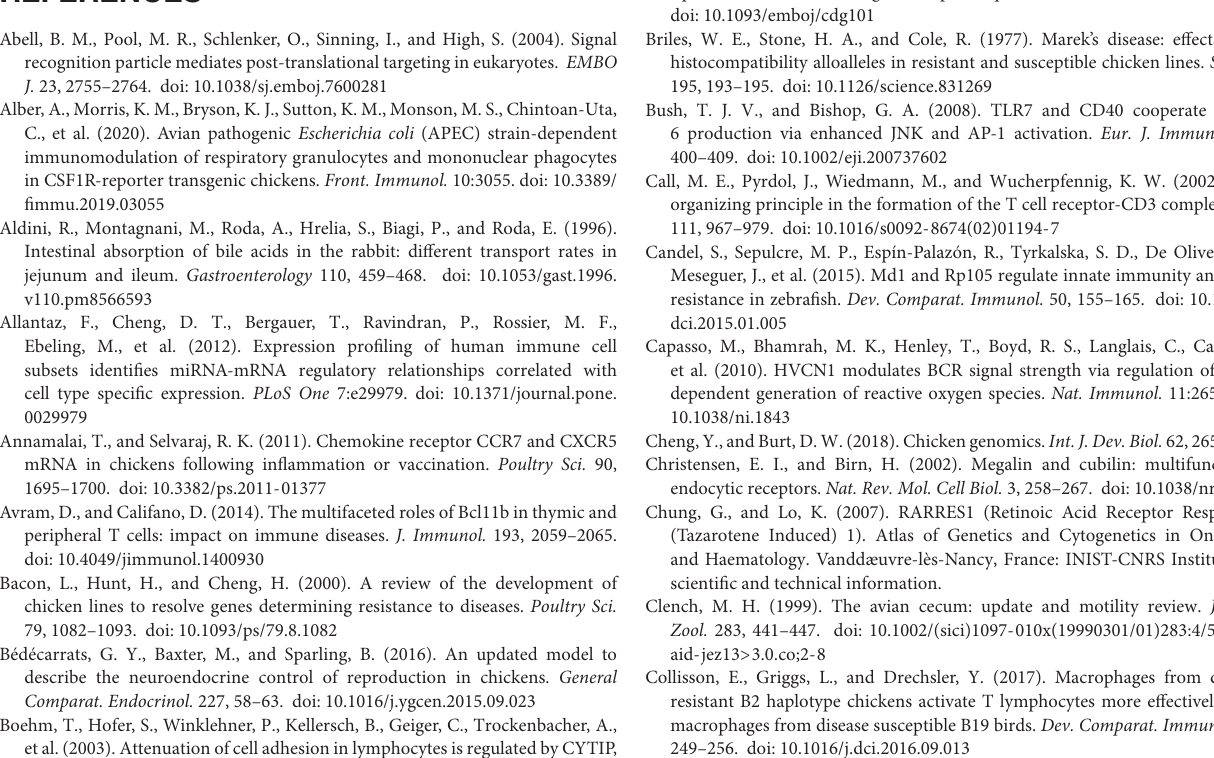
Supplementary Figure 4 | Isoform histograms. (A) Histogram of isoform counts per gene for tissues not included in Figure 3B. The cutout plot in the upper-right corner is a zoomed-in section for 4 + isoforms per gene. (B) GO biological process and molecular function analysis for genes with 4 + isoforms. Supplementary Figure 5 | Extended isoform visualization. (A) Additional sashimi plots from PDGFRB in Figure 3D. (B) Browser shot of the same annotated isoform for the gene PDGFRB .